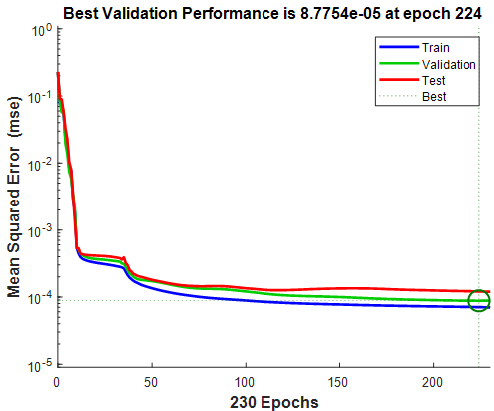
Figure 9. Variation of MSE value with respect to epochs at optimal neural network.